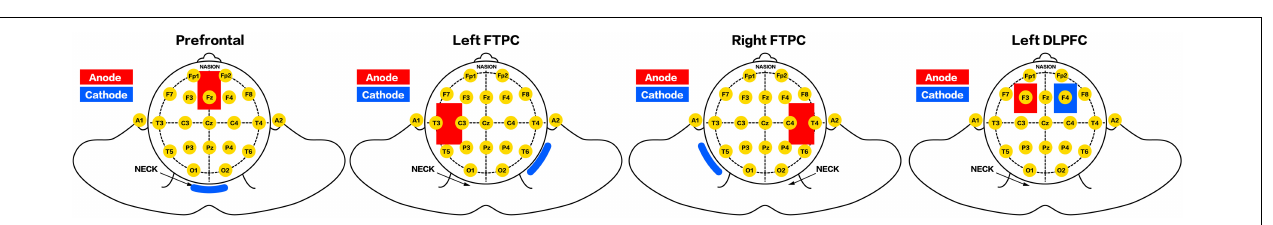
FIGURE 2 | Localization of the transcranial direct current stimulation (tDCS) electrodes.